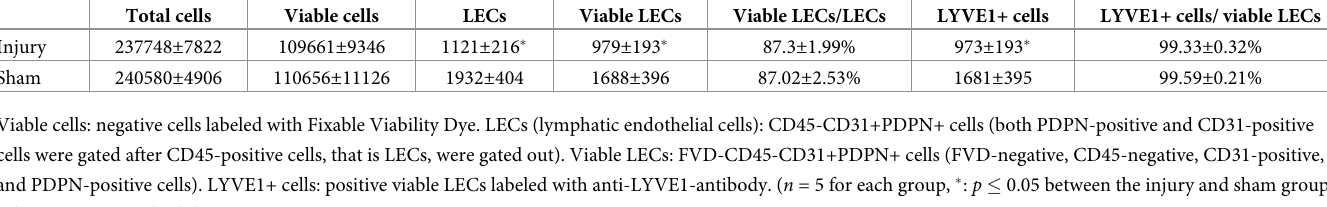
Table 2. Average number of each cell gated by flow cytometry. Total cells Viable cells LECs Viable LECs Viable LECs/LECs Injury 237748 ± 7822 Sham 240580 ±